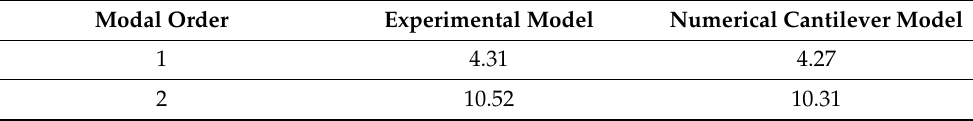
Table 5. Comparison of the natural frequencies of the structure after the main earthquake (Hz). Modal